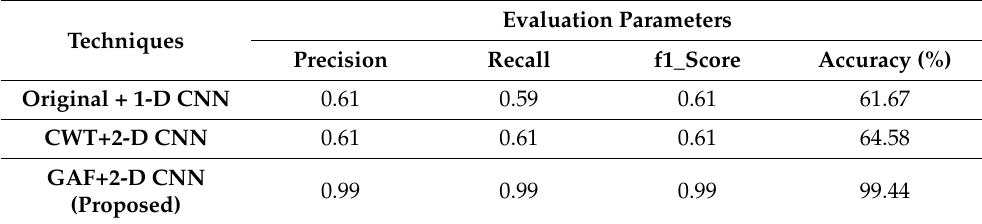
Table 7. The resultant evaluation matrices for three different approaches.